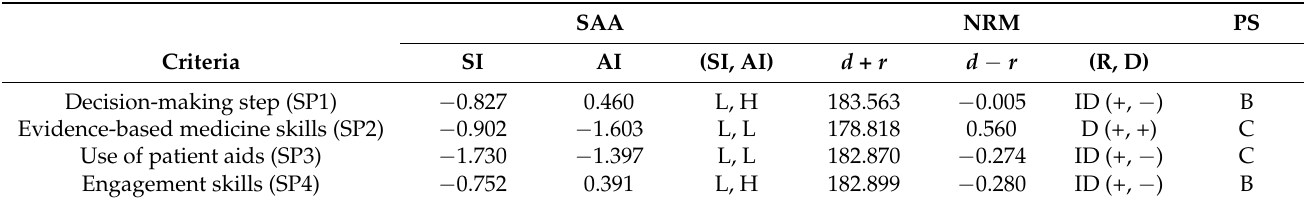
Table 9. The development strategies of the SP (skill and practice) aspect.